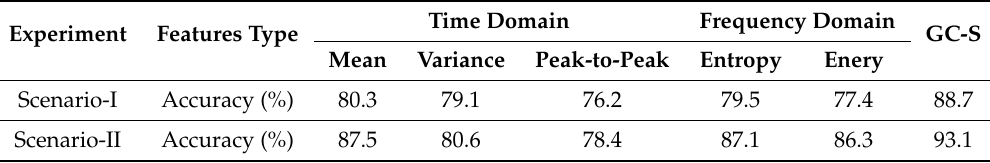
Table 6. Comparison of GC-S technique with conventional